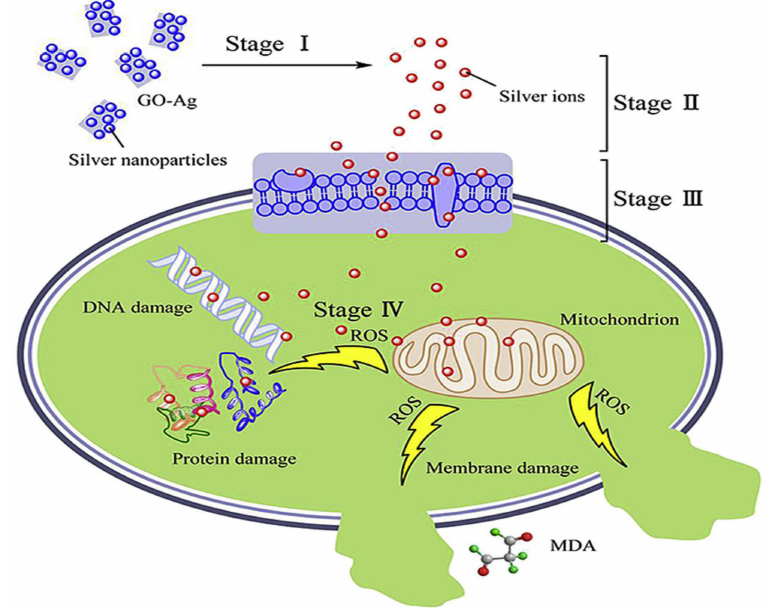
Figure 5. Representation of the antimicrobial action of AgNP-GO nanocomposites. Reproduced from Ref. [60], with permission from Elsevier,